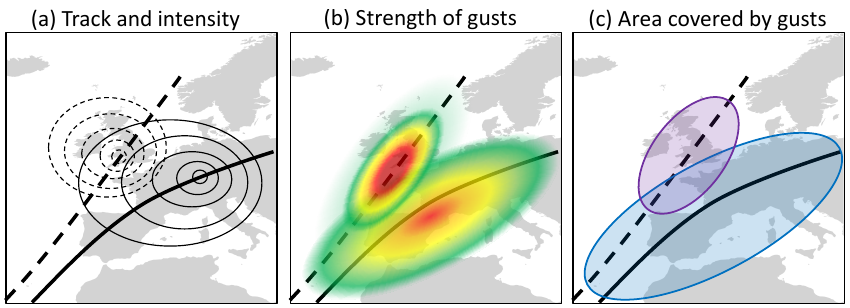
Figure 1. Schematic depiction of the three metrics used to evaluate the predictability of storms: based on the track and intensity of the storms (a) , based on the strength of wind gusts (b) and based on the area covered by unusually strong gusts (c) . See text for